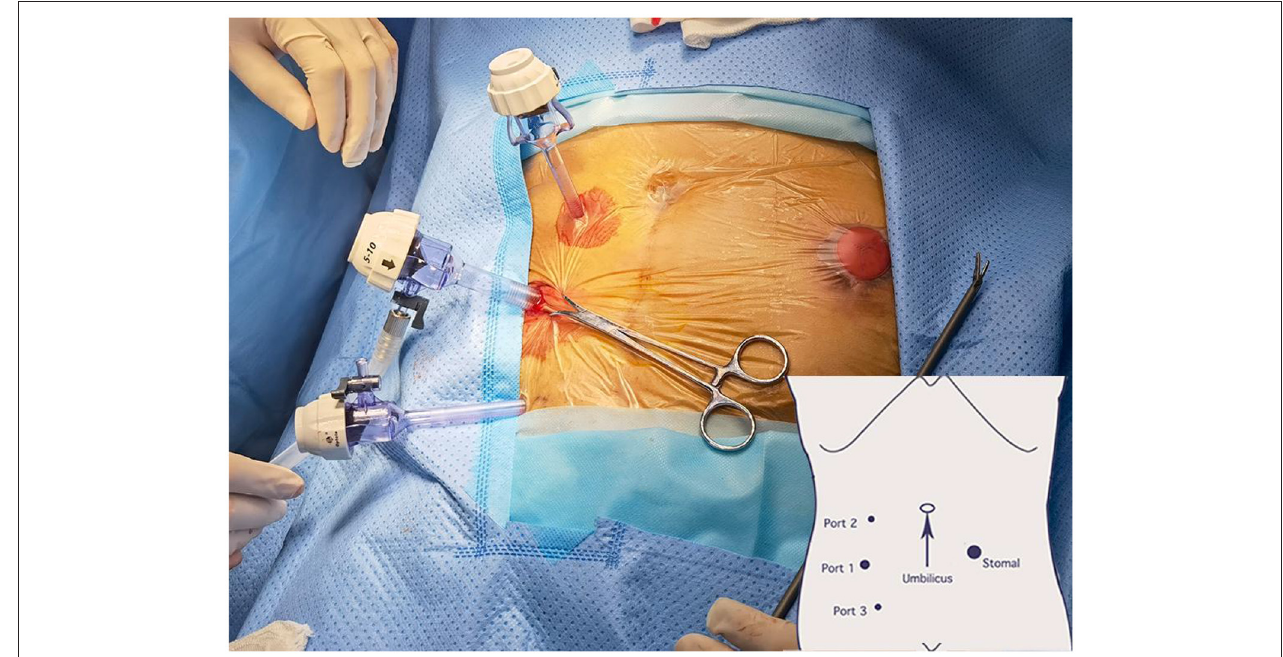
FIGURE 1 | Trocar